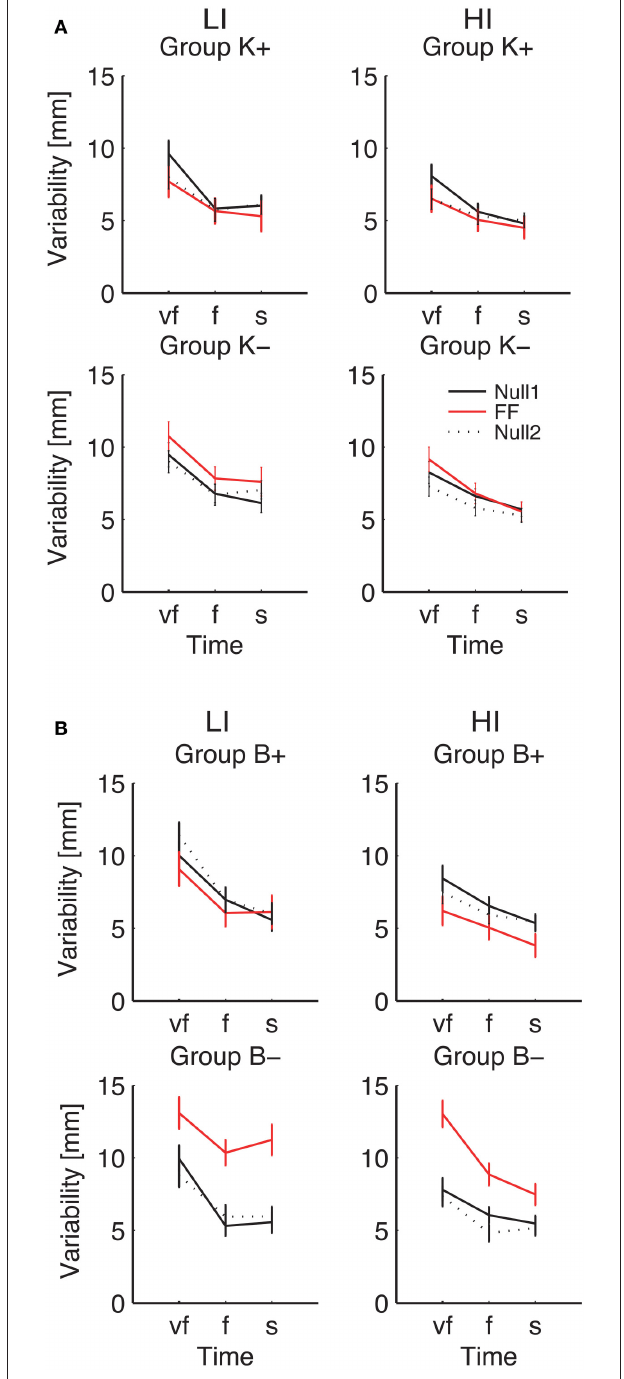
FIGURE 8 | Endpoint Variability vs. Movement Time. Curves are averaged over subjects for each velocity constraint and for each phase – Null1 (black), FF (red), and Null2 (dotted black), on the low inertia (left) and the high inertia (right) direction. We report movements performed with (A) a position-dependent field, and with (B) a velocity-dependent field. The differences between Null1 and FF indicate perturbation effects. The differences between Null1 and Null2 indicate carryover effects. Vertical bars denote the SE